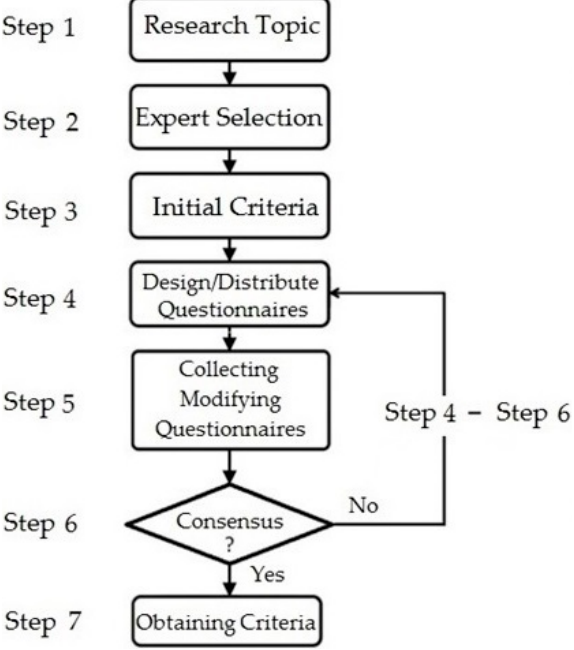
Figure 1. Flow chart for creating a questionnaire using the Delphi method. Table 1. Comparison of Delphi method and Field research